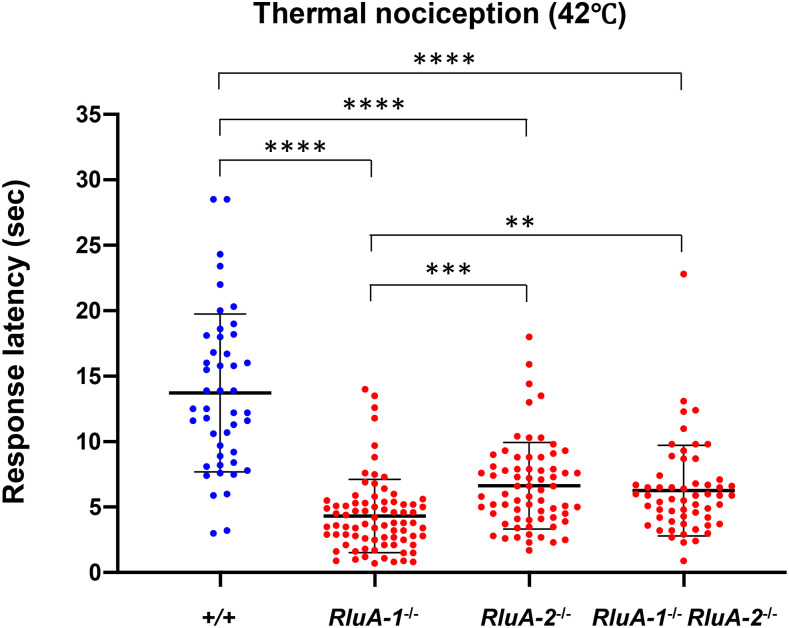
Thermal nociception responses of RluA-1 and RluA-2 single mutant and RluA-1
RluA-2 double mutant. Larvae of single mutant RluA-1del-HDR (RluA-1−/−), RluA-2del-HDR (RluA-2−/−), double mutant RluA-1del-HDR
RluA-2del-HDR (RluA-1−/−
RluA-2−/−) and the genetic background isow1118 (+/+) were stimulated with noxious heat probe of 42°. RluA-1−/−, RluA-2−/−, and RluA-1−/−
RluA-2−/− all displayed faster responses to the stimulus compared to controls (RluA-1−/− average latency of 4.32 ± 2.80 sec, n= 79; RluA-2−/−, 6.63 ± 3.31 sec, n = 68; (RluA-1−/−RluA-2−/−), 6.26 ± 3.46 sec, n = 57; +/+, 13.72 ± 6.03 sec, n = 46). Significance of comparisons are marked as ** (P < 0.01), *** (P < 0.001) or **** (P < 0.0001). Data were analyzed using Kruskal-Wallis test with Dunn’s multiple comparison tests. Error bars in all the figures represent S.D.